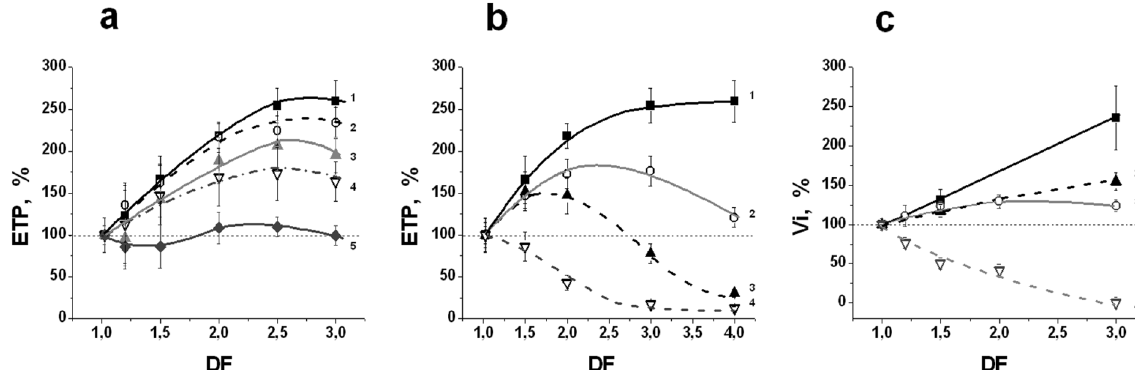
Figure 7. Thrombin inhibitors decrease dilution-induced hypercoagulation. The value of the corresponding parameter in undiluted plasma was taken as 100%. DF is a dilution factor. ( a ) - The increase of ETP during plasma dilution with NS decreases in the presence of AT. The final concentration of AT for each curve was constant and equal to (1) – 0; (2) – 0.145; (3) – 0.29; (4) – 0.58; and (5) – 0.87 IU/ml (n = 5–9). The ETP in diluted plasma differed from that in starting plasma in each series of experiments significantly beginning from DF = 1.5 for all the concentrations of AT, excepting 0.87 IU/ml (ANOVA, P < 0.05 ). The difference between the curves with and without AT was significant for DF = 2.5, 3 (curve 2); DF = 2, 2.5, 3 (curves 3 and 4); and DF = 1.5, 2, 2.5, 3 (curve 5). ( b ) – Changes of ETP in plasma diluted with NS supplemented with different concentrations of the direct thrombin inhibitor HC-025s-IOC. The concentration of the inhibitor in PE was equal to: (1) – 0; (2) – 0.25; (3) – 0.5; and (4) – 1 µ М (n = 3). Coagulation was activated using TF (4 pM). The difference between the initial plasma and the same diluted plasma was significant for all DFs at any concentration of inhibitor (ANOVA, P < 0.05 ). The difference between the curves in the presence and absence of inhibitor was significant for all the curves, excluding curves 2 and 3 at DF = 1.5. ( c ) - Initial clot growth rate (Vi) under plasma dilution with NS in the presence of different concentrations of thrombin inhibitors, and under the different methods of coagulation activation (n = 3 pools, each of 3 plasma samples). (1) - Contact activation (glass, n = 3); (2) - contact activation and AT in all the samples at the concentration of 0.87 IU/ml (n = 3); (3) – activation by TF (4 pM, n = 3); (4) – activation by TF and dilution with NS containing 8 µ М of the thrombin inhibitor HC-025s-IOC (n = 3). The mean values ± SD are shown. All the obtained differences